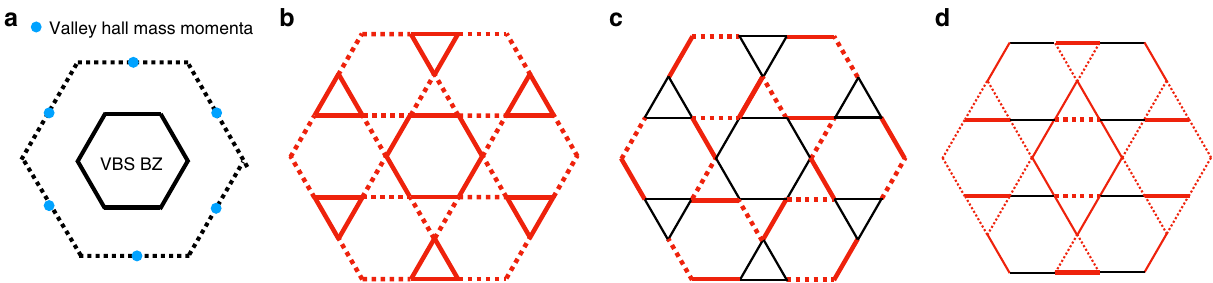
Fig. 3 Kagome lattice VBS. a The momenta of M 0 i and V i ’ s on kagome lattice yielding the reduced Brillouin zone for VBS pattern with an area a quarter of the original one. Panel b – d are examples of high-symmetry VBS patterns on kagome lattice resulting from chiral symmetry breaking and monopole proliferation. The solid/dotted red bonds denotes positive/negative VBS weight with width indicating strength. Weight vanishes on black bonds. Patterns b and c result both from condensation of mass M 01 + M 02 − M 03 , but with the corresponding monopole Φ y h Φ y i ¼ 1 ; i , respectively. Pattern d results from mass M 02 with hV y 1 þ i V y 3 i ¼ e (cid:2) i π 4 , which preserves R y but breaks C 6 . Pattern b is symmetry equivalent to kag the Hastings VBS of ref. 24 , and Pattern d is symmetry equivalent to the VBS found by DMRG proximate to the spin liquid phase in ref. 56 (panel c of Fig.